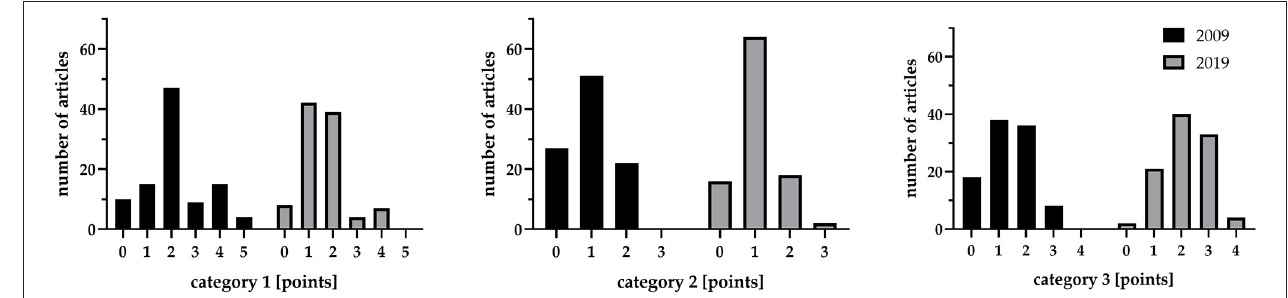
FIGURE 2 | Quality score according to the three analyzed categories: “anesthesia monitoring”–category 1, “ischemia verification”–category 2 and “general quality standards”–category 3.